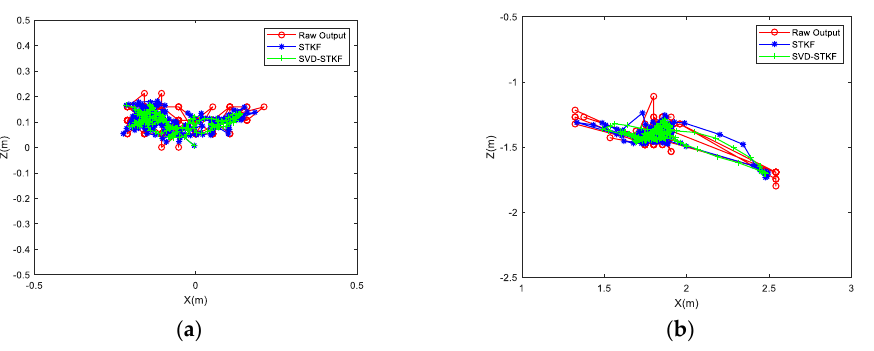
Figure 16. Distribution of rotation anchor points of the source. ( a ) (0, 0) location distribution. ( b ) (2, −1.5) location distribution.